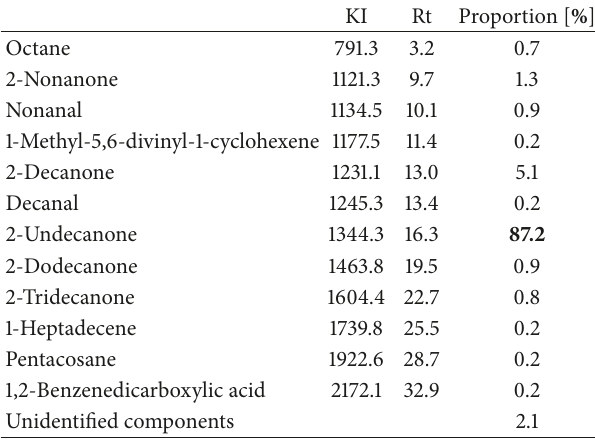
Table 2: Chemical composition of Ruta chalepensis L.essential